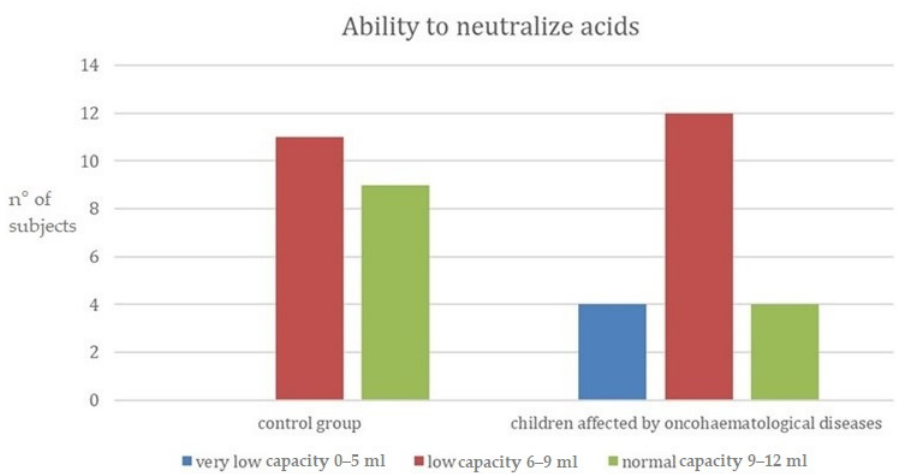
Figure 4. Ability of saliva to neutralize acids. (Y axis: n° of subjects = number of subjects for each category).